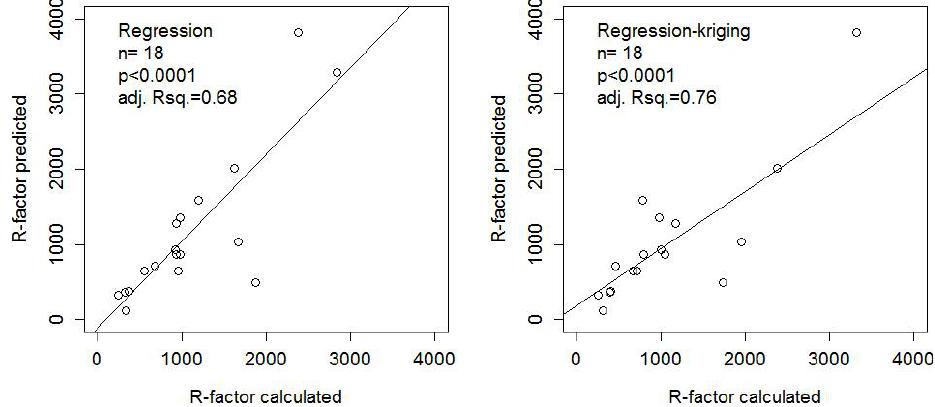
Fig. 2. Scatterplot between calculated and predicted R -factor values for the validation dataset: after the multiple regression (left) and after the regression-kriging (right).